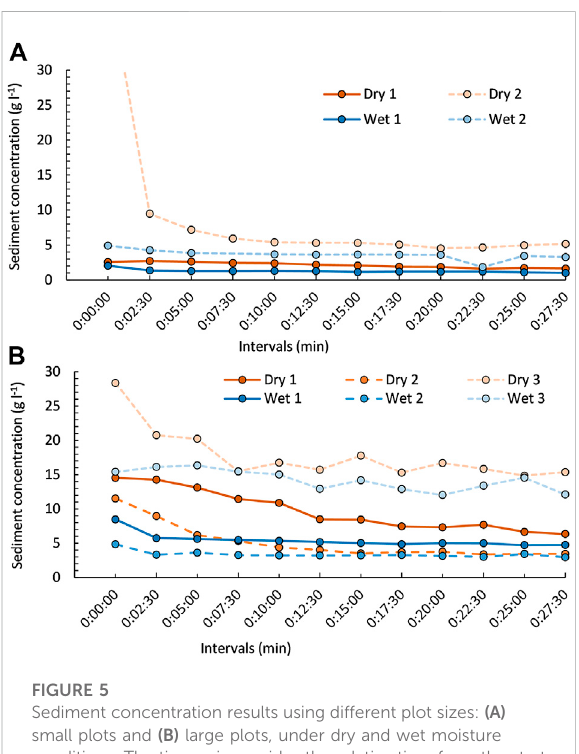
FIGURE 5 Sediment concentration results using different plot sizes: (A) small plots and (B) large plots, under dry and wet moisture conditions. The time axis provides the relative time from the start of the surface